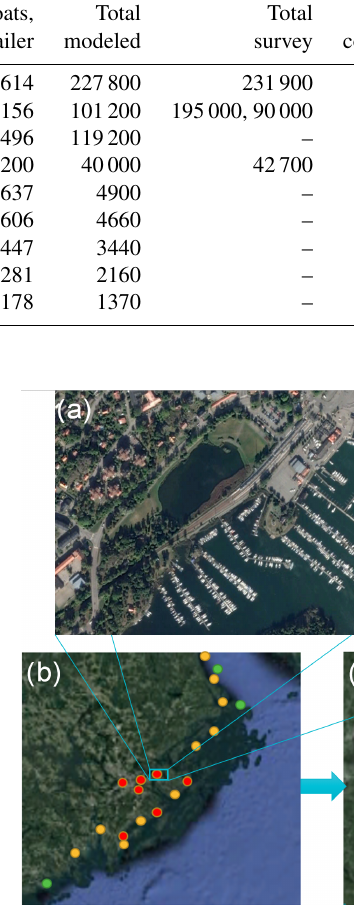
Figure 7. The overall process for geographical distribution of ac- tivities. In (a) , an example of satellite imagery used to calculate the number of boat places in a small boat marina (58.9 ◦ N, 17.95 ◦ E; Sweden). In (b) the analysis for boat counts and marina loca- tions has been applied for a selected region. In (c) an example is given when emissions of selected marinas are allocated according to Eq. (8). Satellite image background provided by © Google Earth.